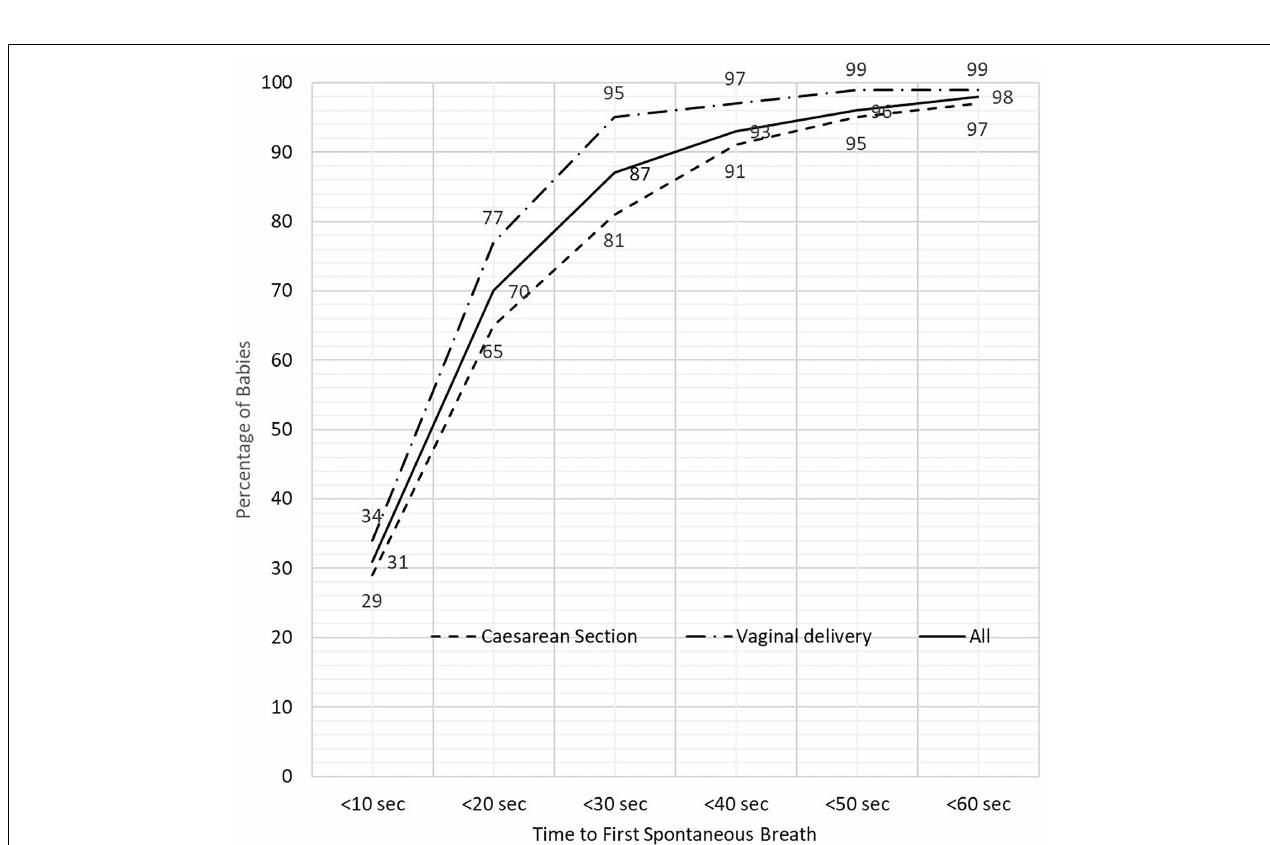
FIGURE 1 | The number of deliveries and proportions requiring stimulation, bag mask ventilation, and chest compressions.